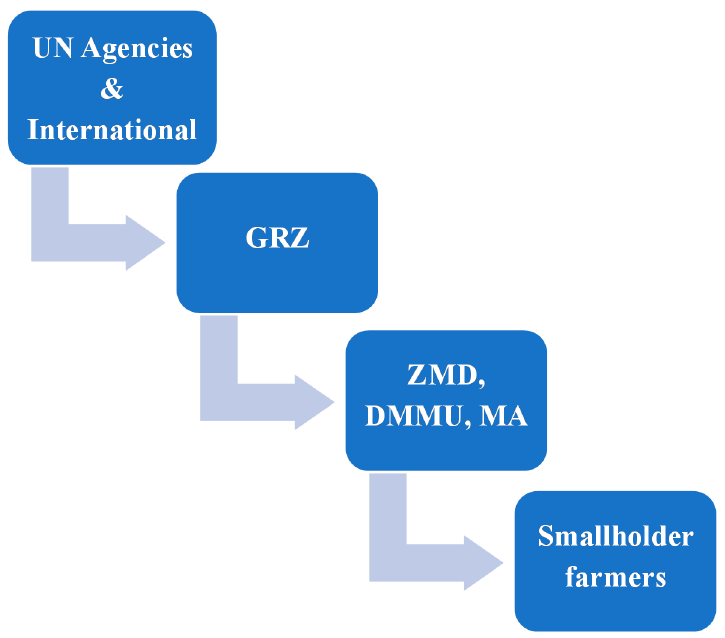
Figure 2. Institutional support structure providing climate disaster preparedness as perceived by smallholder farmers. UN, United Nations; NGOs, Non-Governmental Organizations; GRZ, Gov- ernment of the Republic of Zambia; ZMD, Zambia Meteorological Department; DMMU, Disaster Management and Mitigation Unit; MA, Ministry of